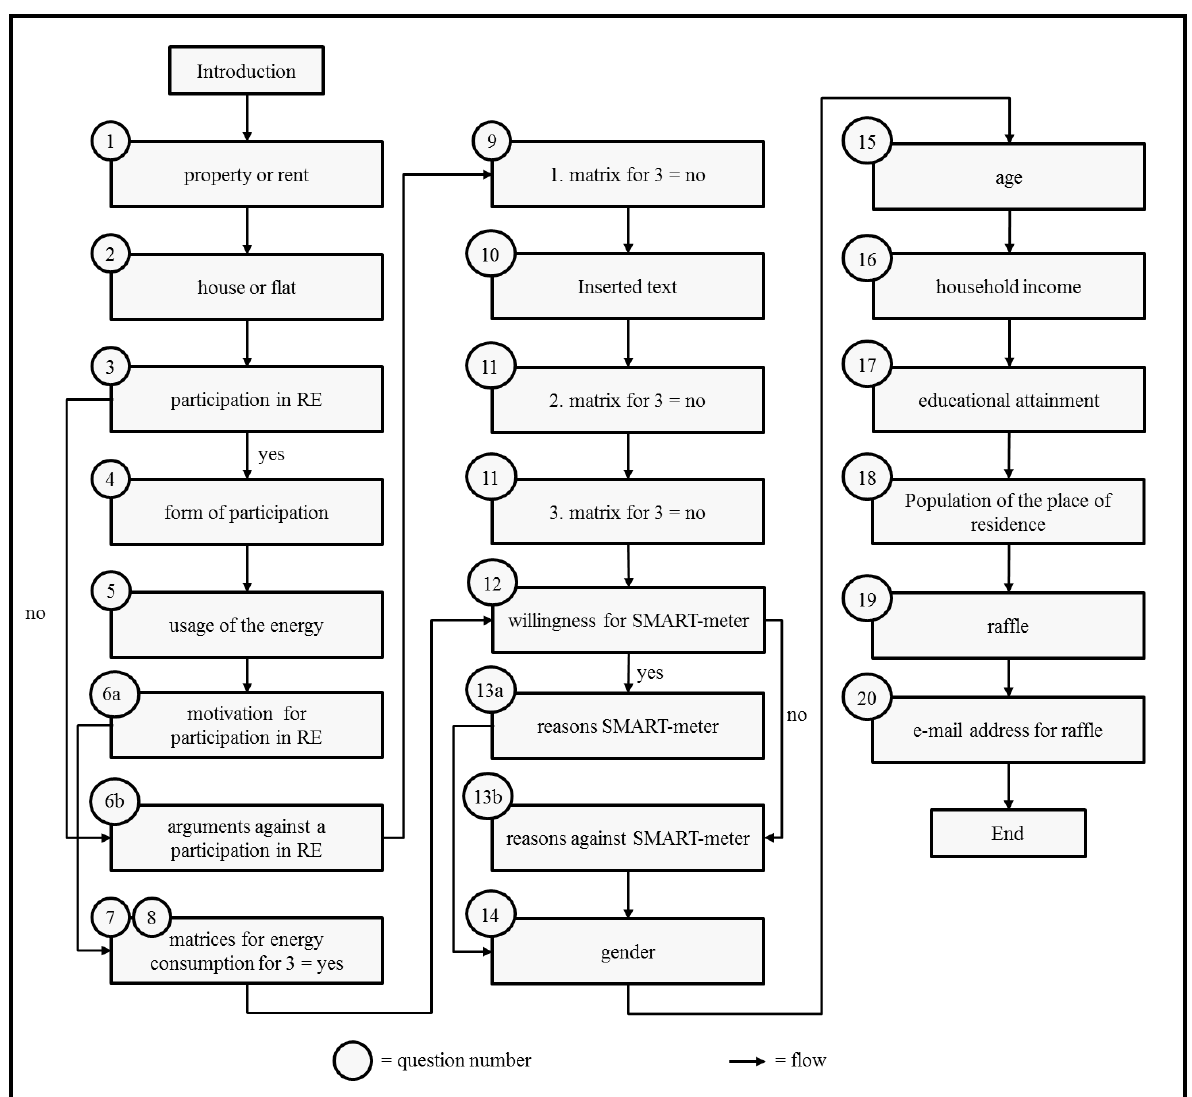
Figure A1. Questionnaire flow participants had to go through.